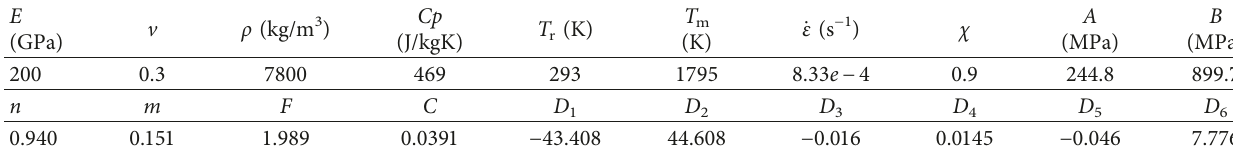
Table 1: Material constants of Q235B steel.